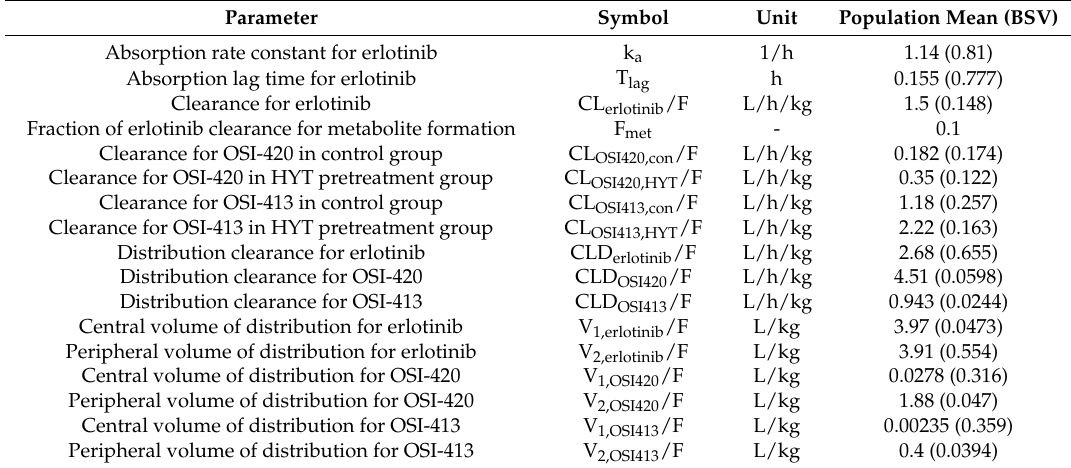
Table 3. Population pharmacokinetic parameter estimates of erlotinib and its active metabolites, OSI-420 and